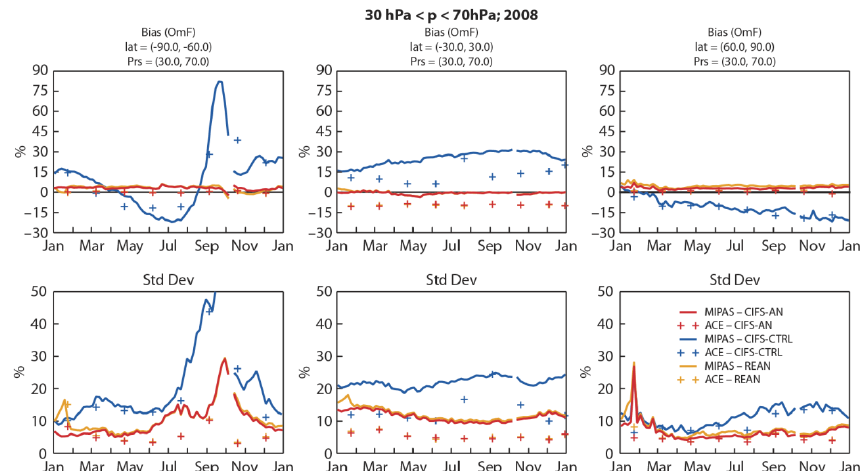
Figure 13. Time series for 2008 of monthly mean differences (top) and SD (bottom) in % of the experiments, ACE data (plus symbols) and MIPAS data (solid) averaged over the pressure range between 30 and 70hPa, for the Antarctic (90 to 60 ◦ S, left), the tropics (30 ◦ S to 30 ◦ N, centre) and the Arctic (60 to 90 ◦ N, right). CIFS-AN is shown in red, CIFS-CTRL in blue, and REAN in orange.